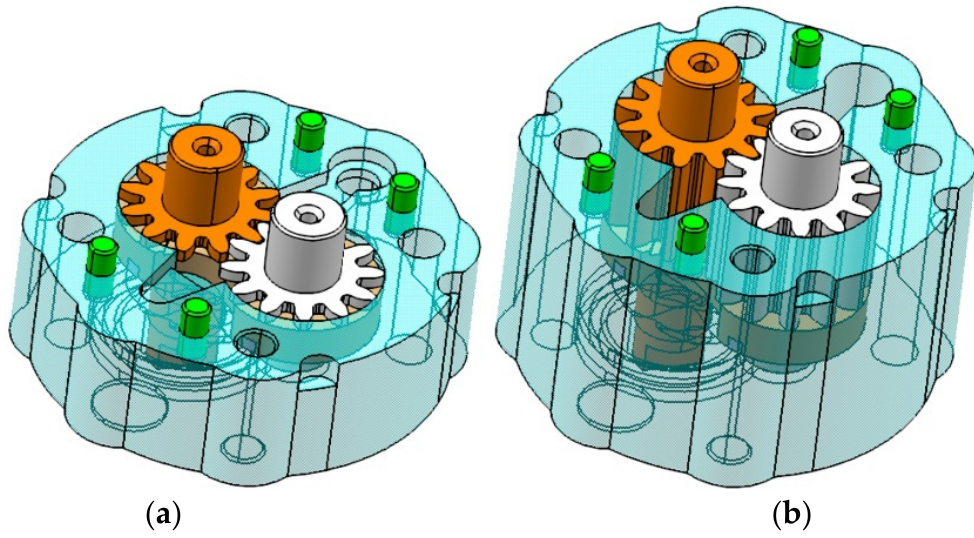
Figure 4. Parametric model of the pump for the flow rate of 2 L/min ( a ) and of 22.52 L/min ( b ). Certain standard components of the assembly (i.e., cover, screws and gaskets) were not represented in the figure to simplify it and only to highlight how the parameterized components are